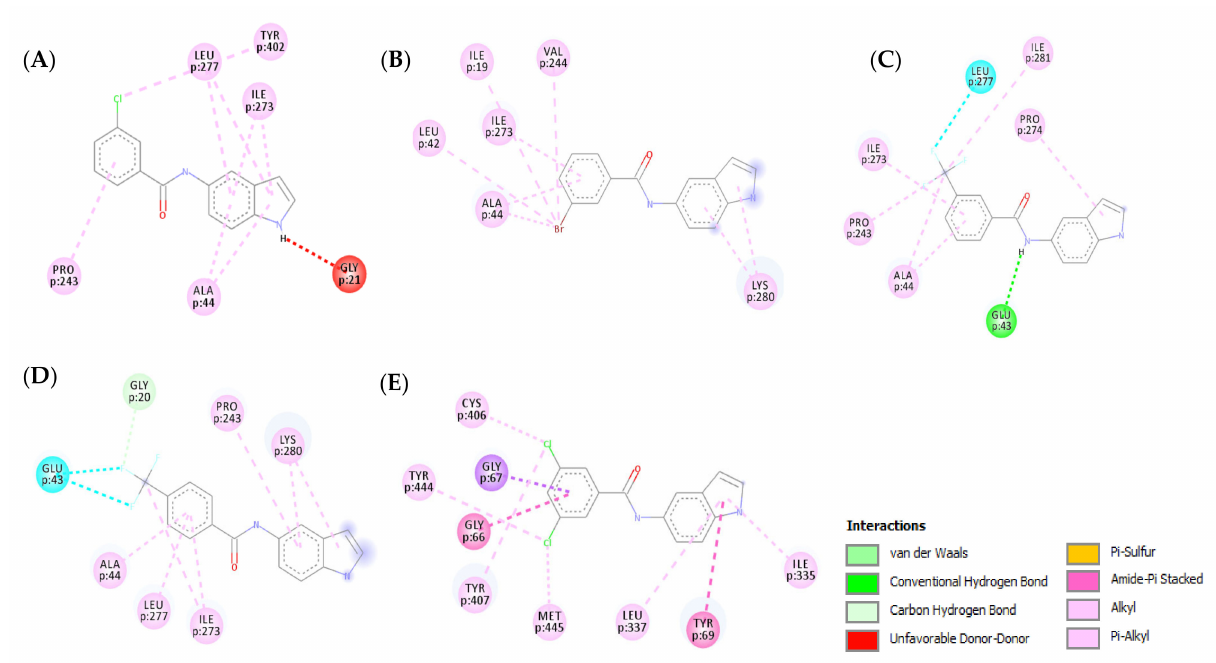
Figure 10. Two-dimensional (2D) interaction models of compounds 3n ( A ), 3r ( B ), 3u ( C ), 3v ( D ), and 3w ( E ) into the active site of